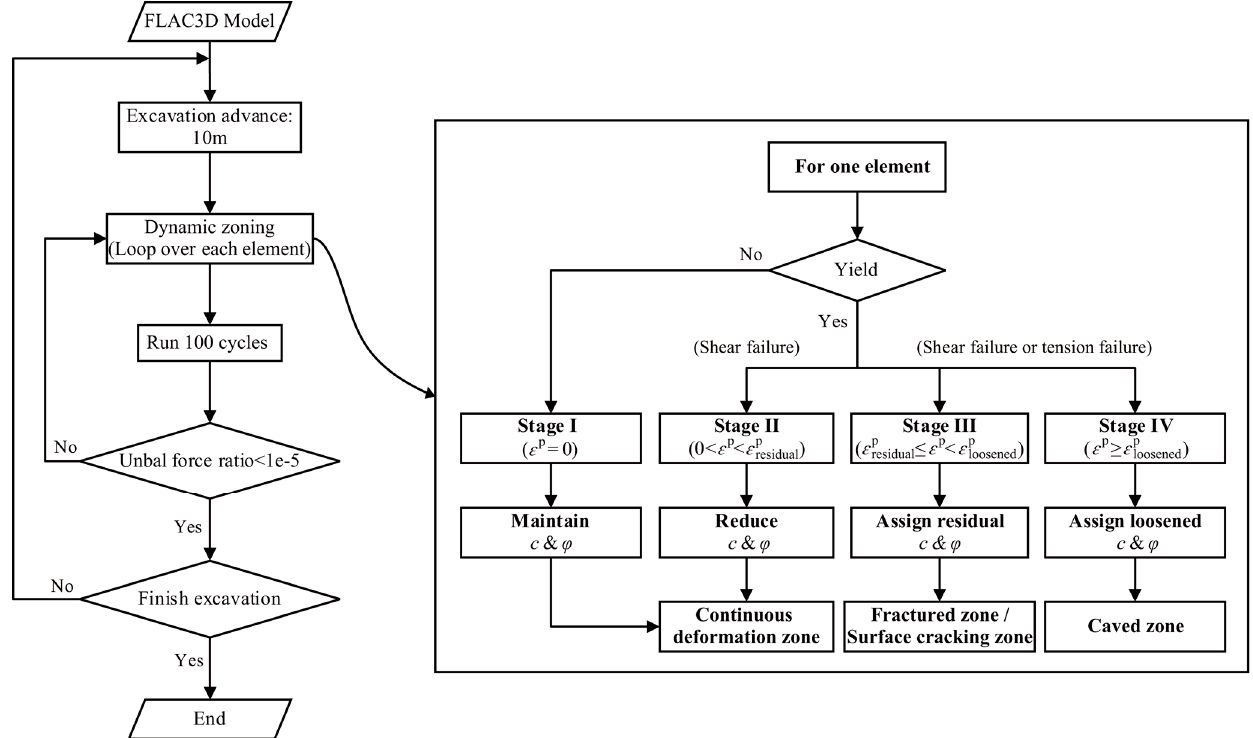
Figure 7. Flowchart for the simulation of longwall mining and dynamic zoning